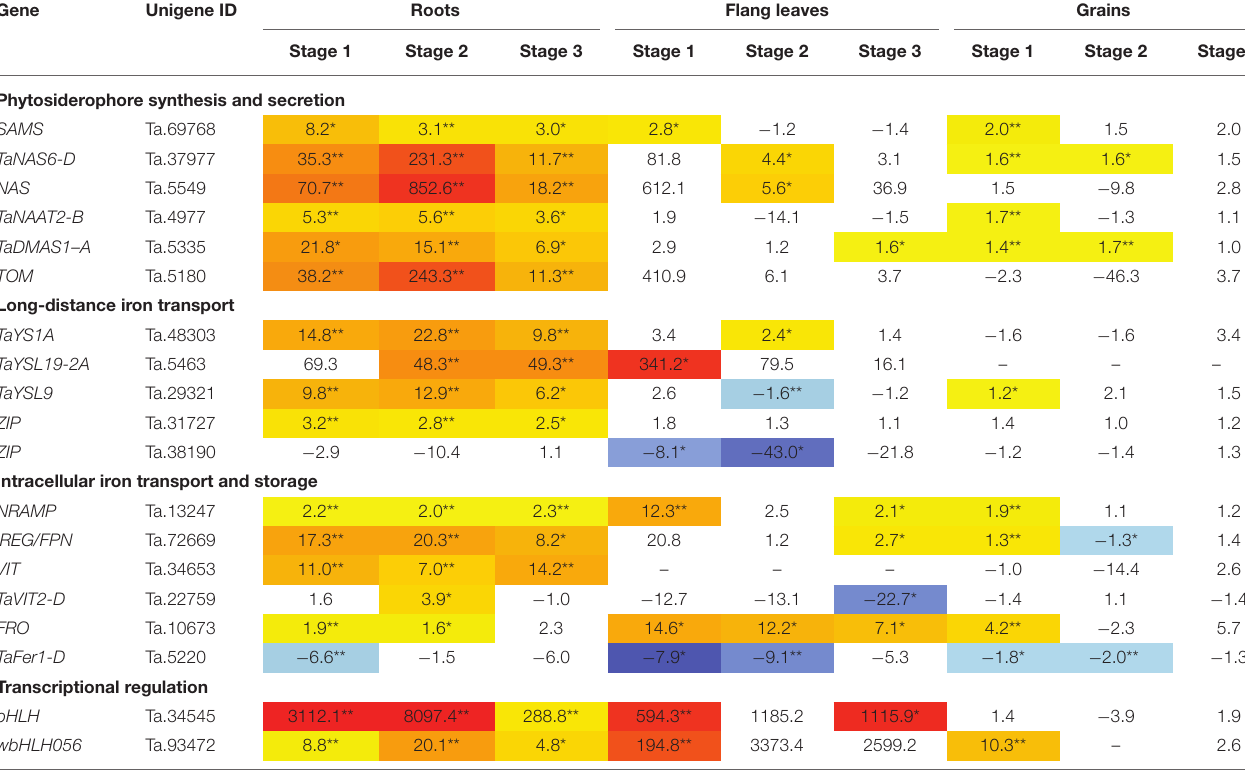
TABLE 1 | Gene expression fold change between iron deficient and sufficient condition in bread wheat. Gene Unigene ID Roots Flang leaves Grains Stage 1 Stage 2 Stage 3 Stage 1 Stage 2 Stage 3 Stage 1 Stage 2 Stage 3